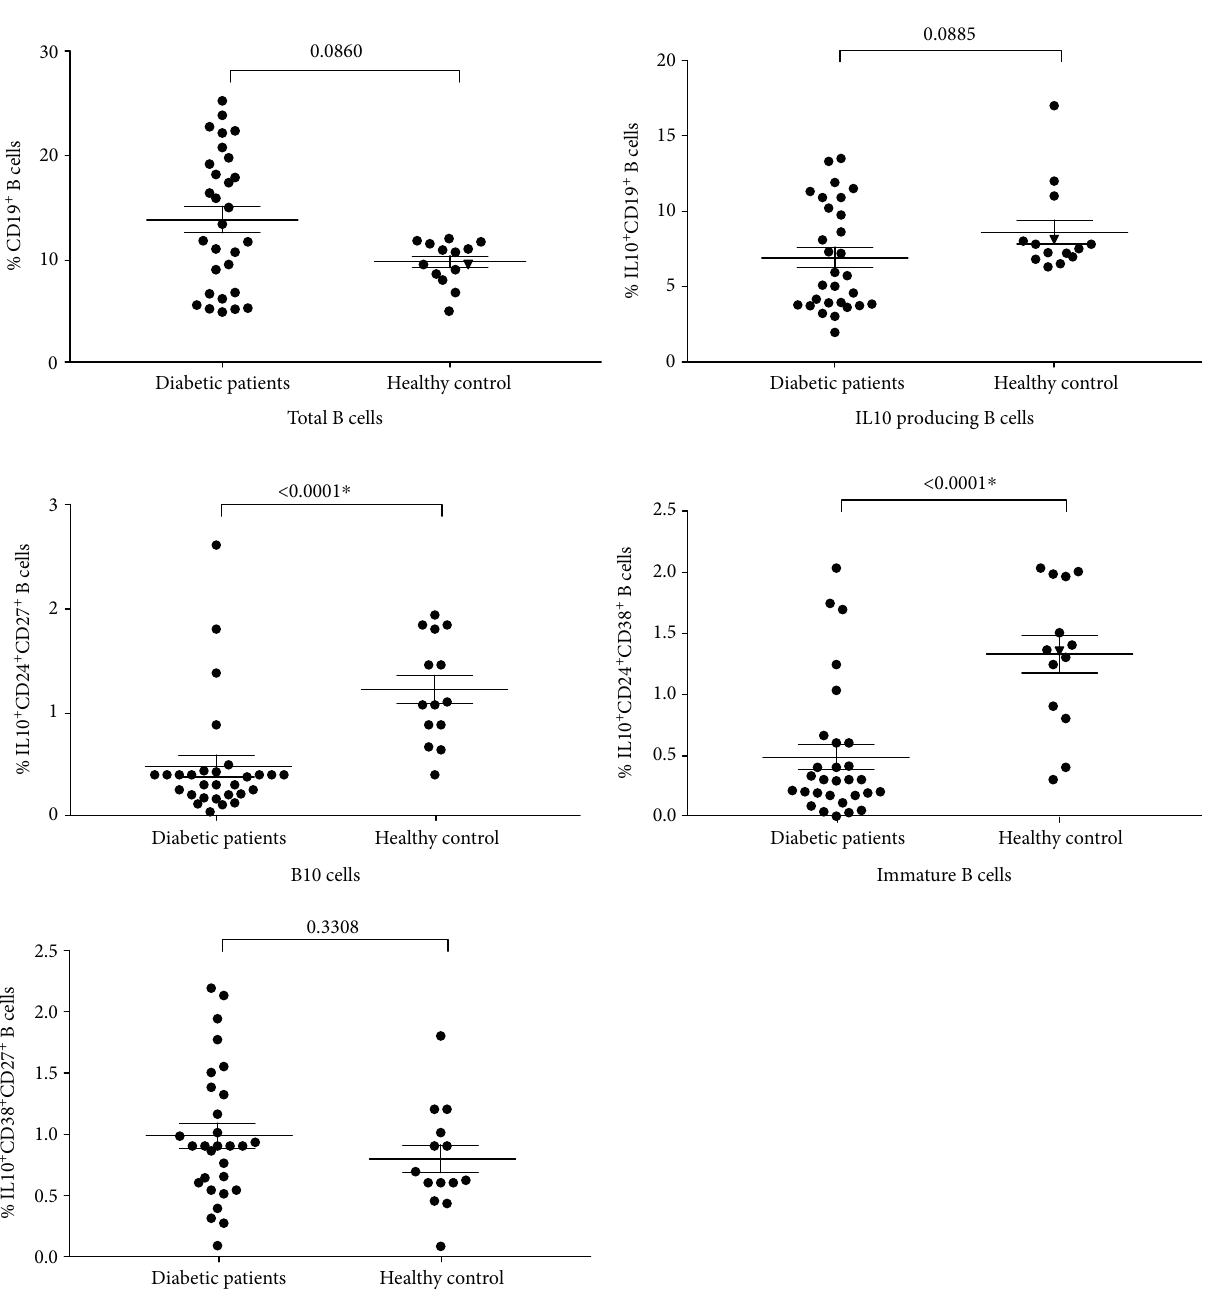
Figure 2: Alterations in the frequencies of di ff erent B cell subset in children with T1D compared to control subjects. Horizontal lines show means ± standard error . ∗ indicate signi fi cance ( P < 0 : 05